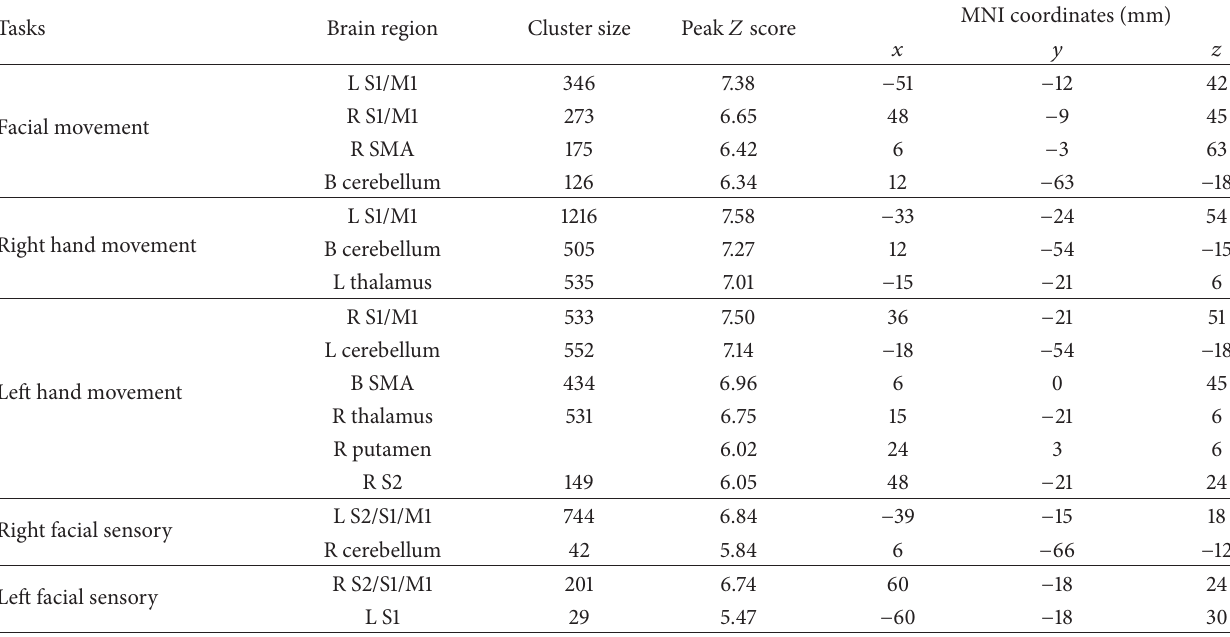
B, bilateral; L, left; M1, primary motor cortex; R, right; S1, primary somatosensory cortex; S2, secondary somatosensory cortex; SMA, supplementary motor